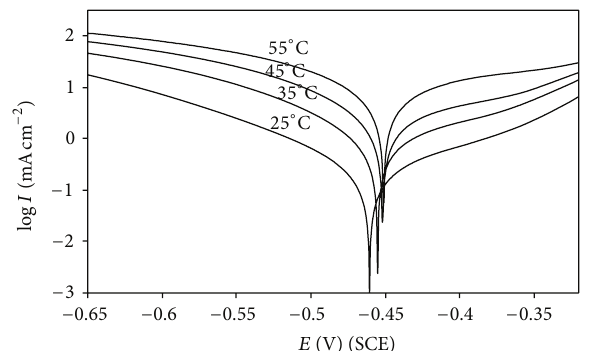
Figure 4: Effect of temperature on the cathodic and anodic responses for C38 steel in 1M HCl + 0.2 mM of